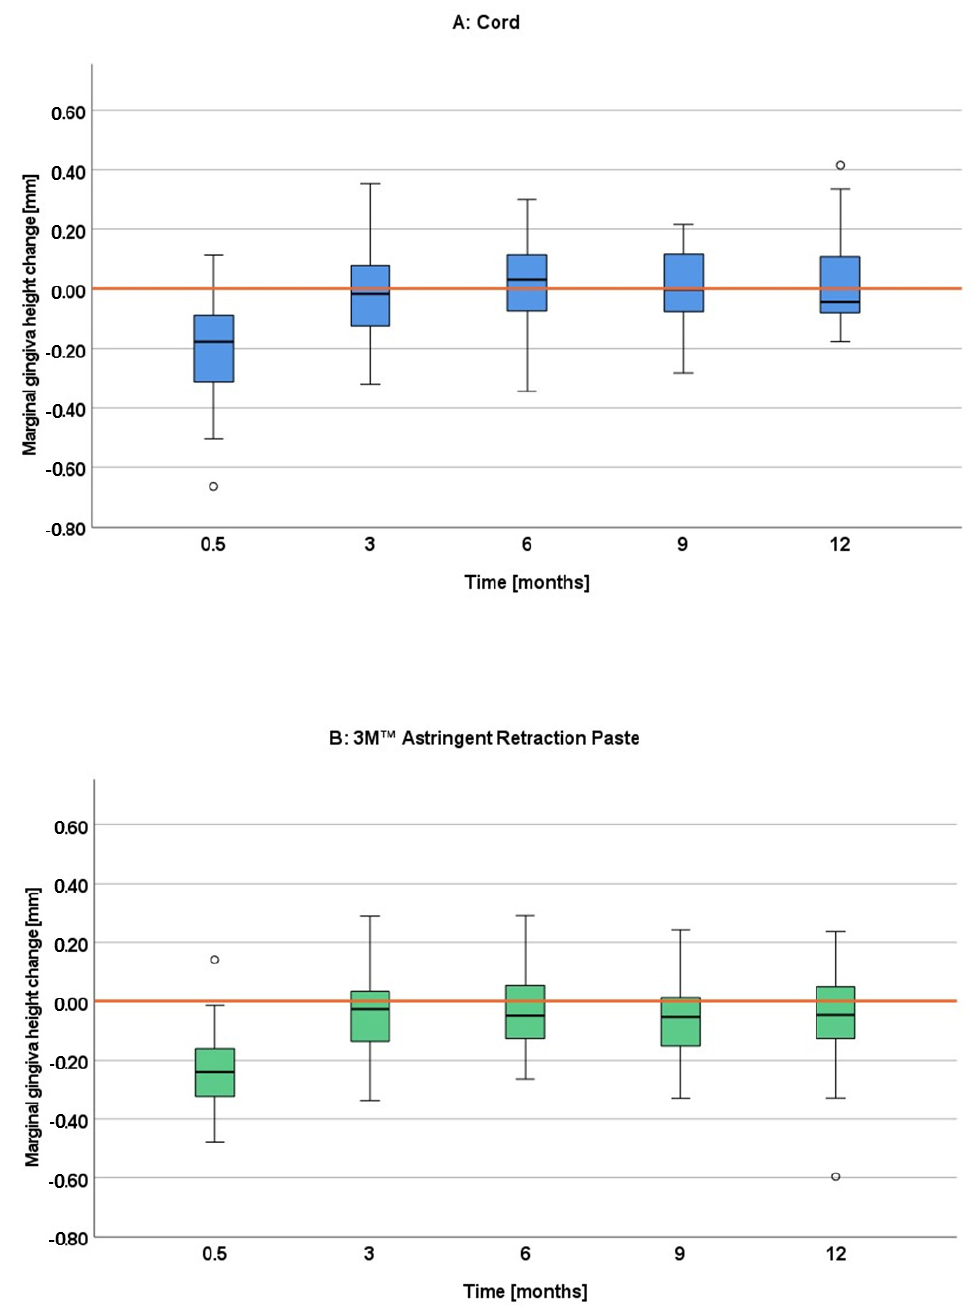
Figure 8. Marginal gingiva height changes between reference and intervention model (0.5 months) and between reference and control models (3, 6, 9, 12 months); negative value: loss of marginal gingiva height compared to the reference model; the circles represent outlier values (more than 1.5 times the box width away). Table 5. Comparison of marginal gingiva height change between cord and paste group.